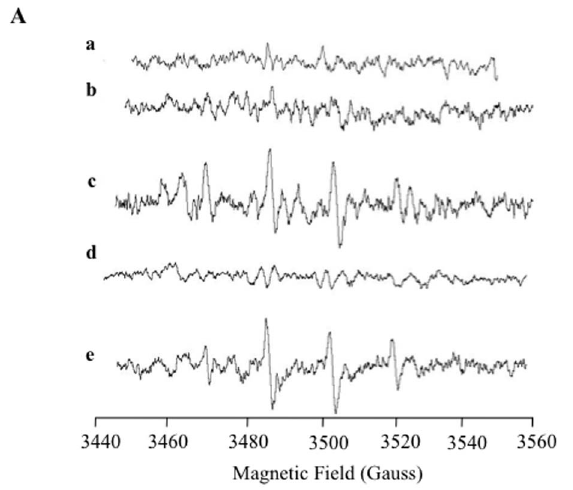
Figure 3. Superoxide generation in MCF-7 cells treated with mitocur-1 detected by EPR spectroscopy using DMPO spin trap. ( A ) Cells alone; ( B ) Cells + curcumin (10 m M); ( C ) Cells + mitocur- 1Mitocur- (10 m M); ( D ) Cells + mMitocur-1 (10 m M) + MnTBAP (10 m M); ( E ) xanthine + xanthine oxidase. Microwave frequency, 9.786 GHz; micro- wave power, 10 mW; modulation amplitude, 1 G; scan time, 30 s; no. of scans, 10.